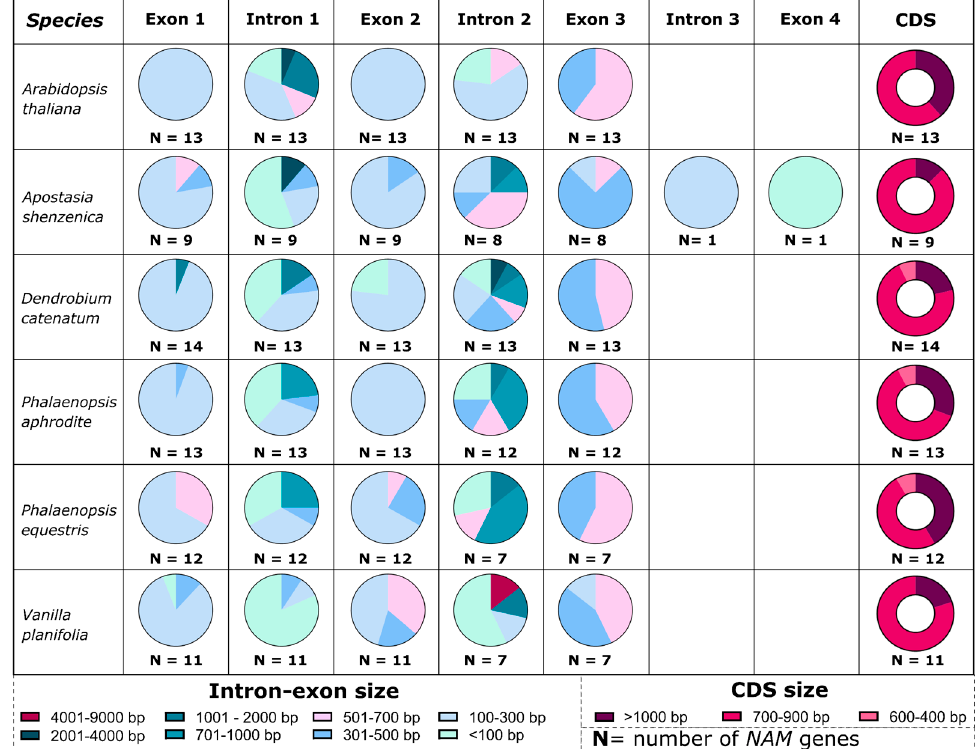
Figure 3. Comparison of NAM gene intron and exon sizes between Arabidopsis and orchids. For each species, the rows represent the intron/exon structure of the NAM genes. The different colors indicate the intron/exon size range. The pie charts show the percentage of genes with a specific size range for each intron/exon (see Supplementary Data S2). The last column shows the size variability in NAM gene CDSs.